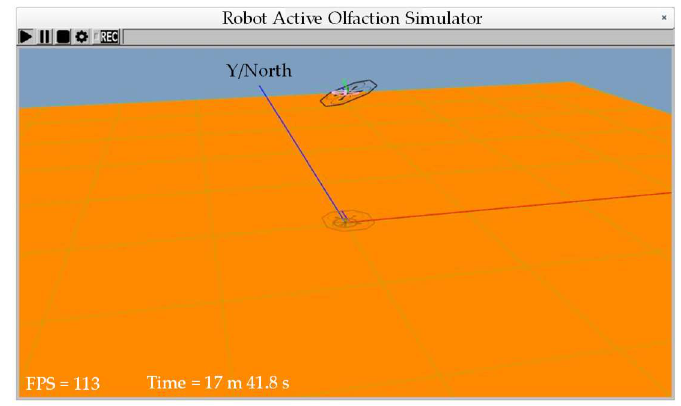
Figure 4. Simulation environment.